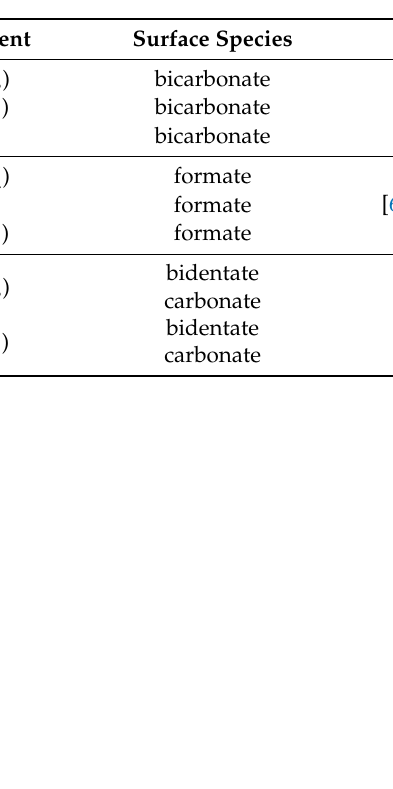
Figure 7. Schematic of surface species observed on MoP/ZrO 2 that are proposed to be responsible for its superior activity for methanol synthesis.